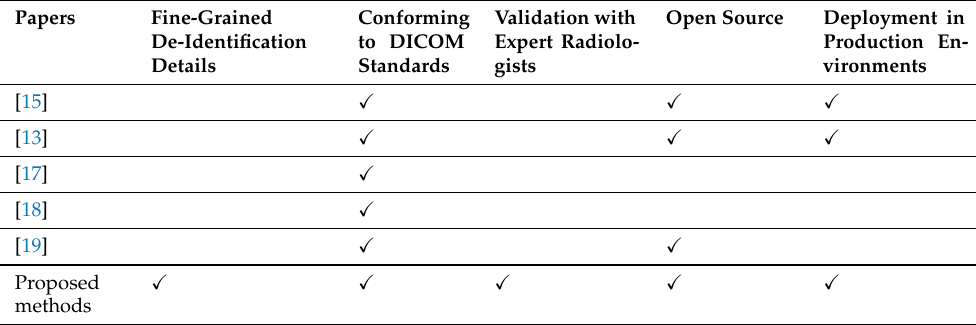
Table 1. Comparative analysis of DICOM de-identification methods and tools.